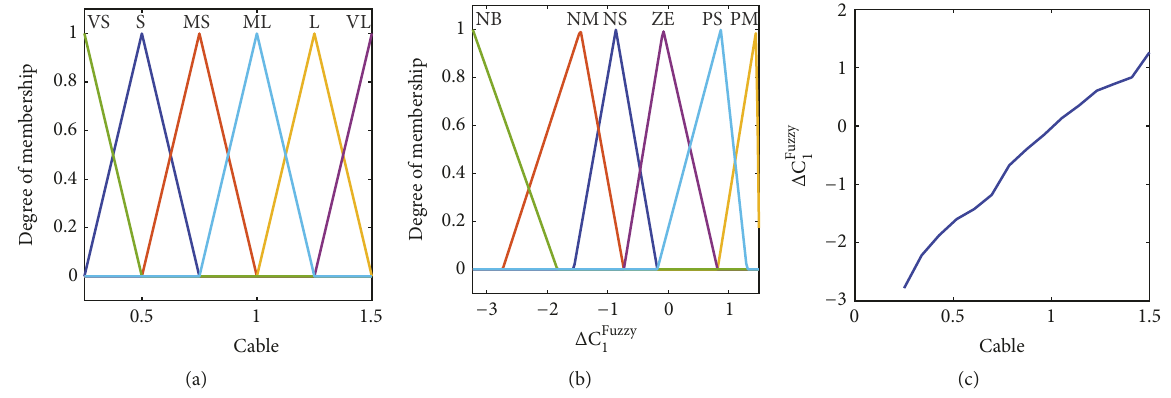
Figure 5: Fuzzy: (a) input MFs; (b) output MFs; (c) input-output characteristics.